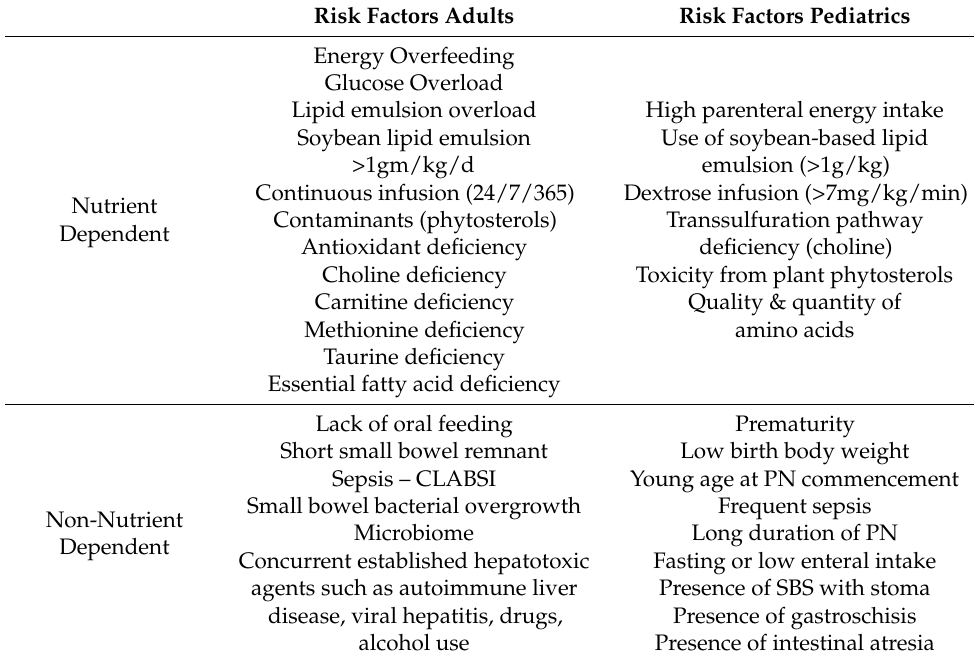
Table 1. Risk Factors for Liver Disease in Adult and Pediatric Patients on Long-term Parenteral Nutrition.